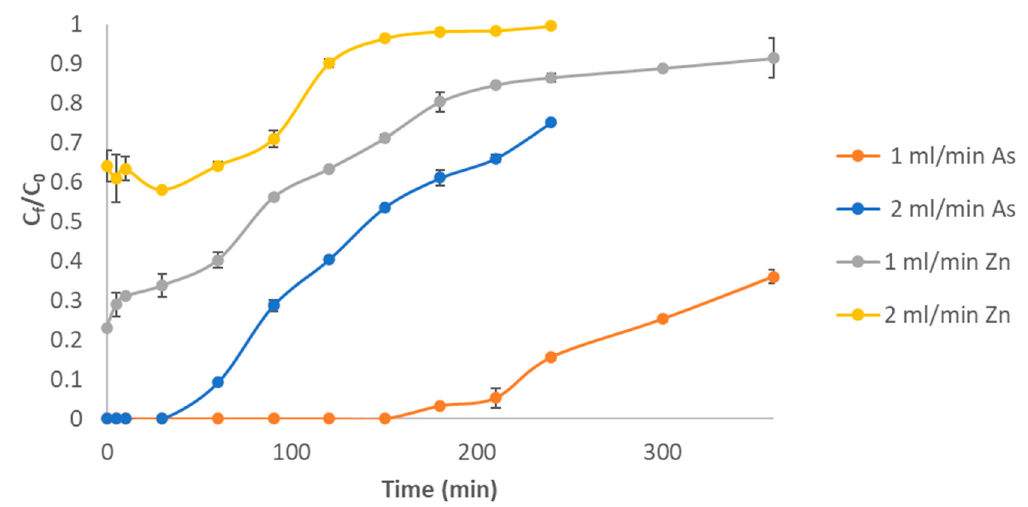
Figure 7. Arsenic and zinc sorption breakthrough curves of drop-fed columns with alginate beads containing biogenic iron compounds using different feed flow rates (3 cm of bed height (7.87 g of adsorbent)).